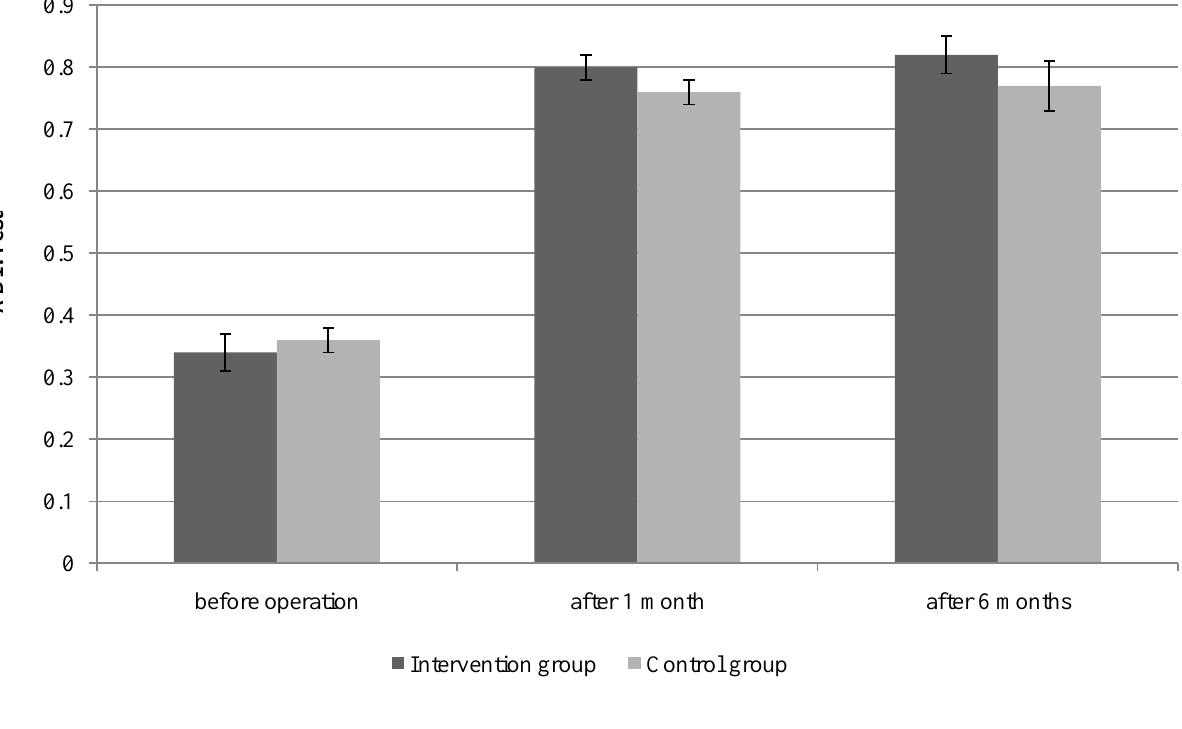
Table 2. Health-related quality of life at baseline and at 6 months after the surgery in the intervention (n = 57) and control groups (n = 60).